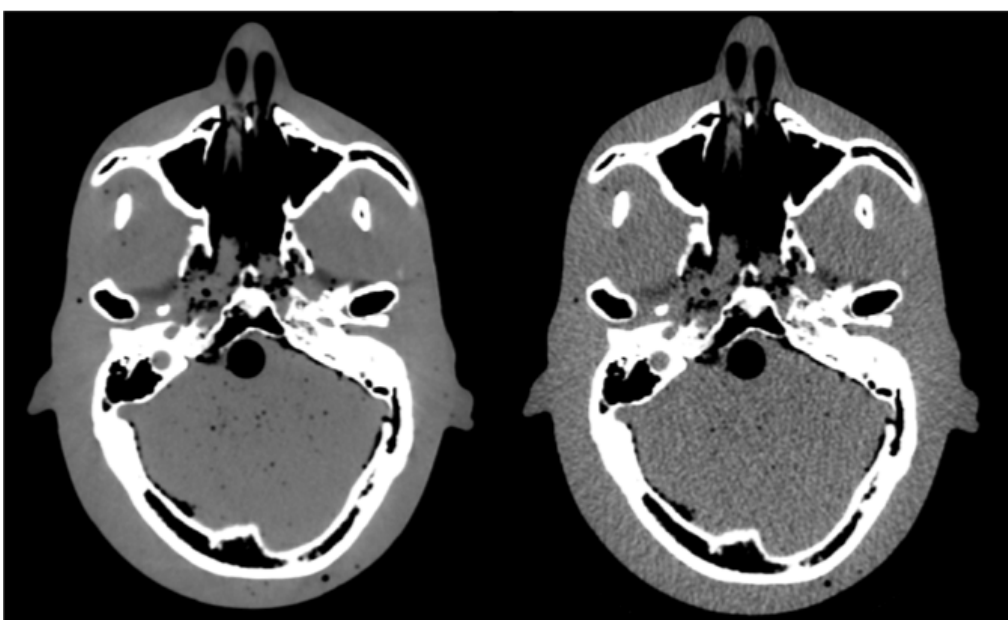
Figure 2. Pair of CT images of head phantom: standard protocol ( left ) and low-dose protocol ( right ).